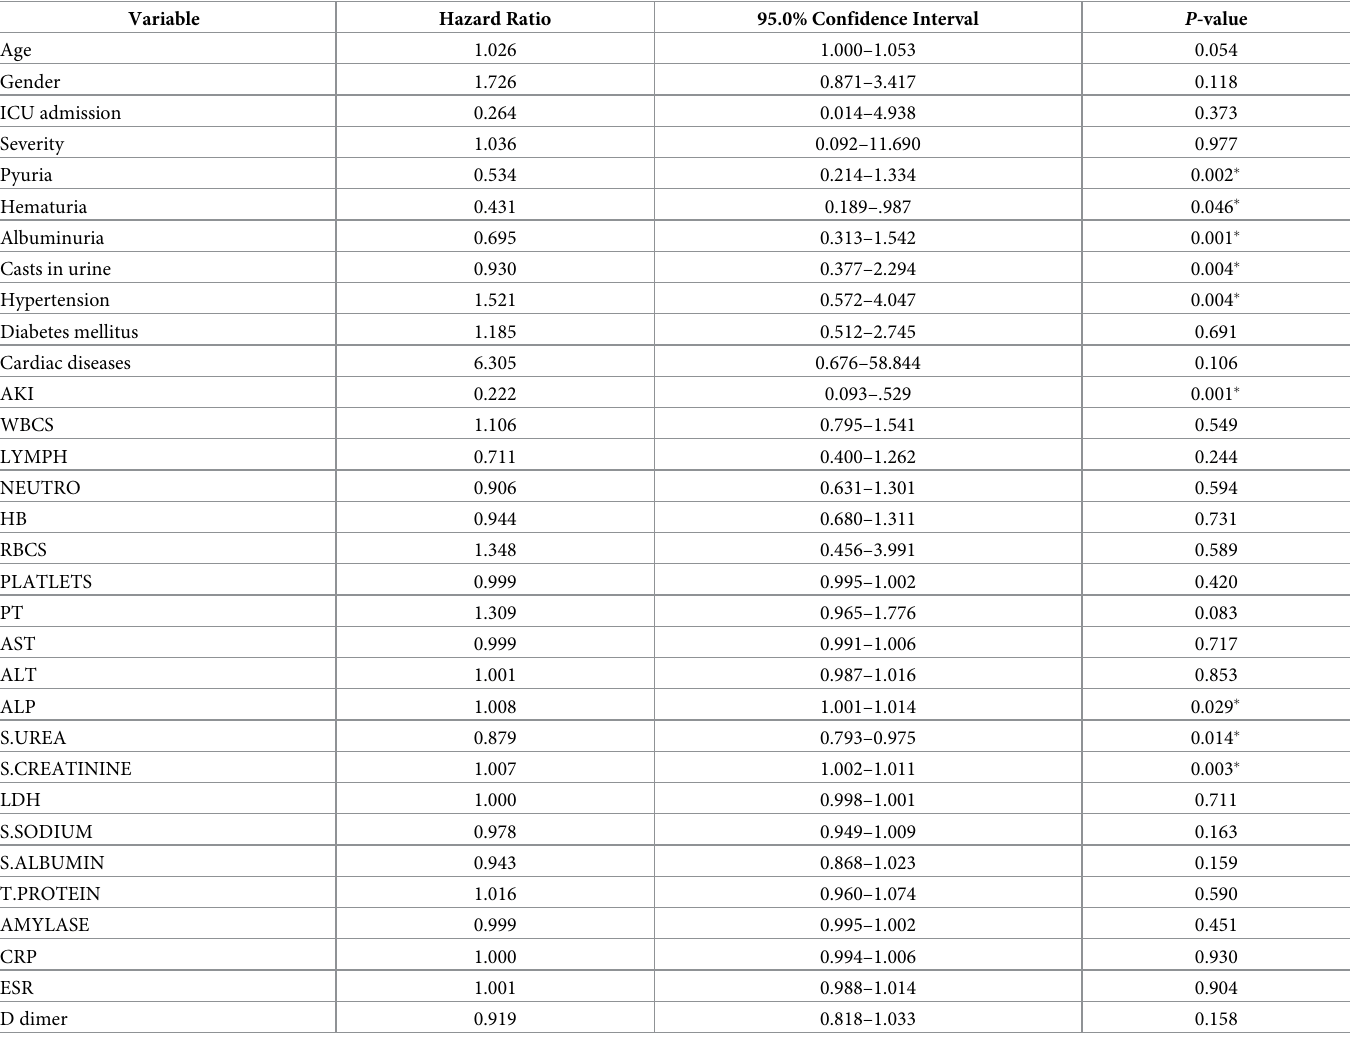
showed that age and hypertension, in addition to renal manifestations in the form of AKI, hematuria, proteinuria, pyuria, and presence of casts, were significant risk factors for mortality in patients with COVID-19 (Table 5). Table 5. Multivariate COX regression analysis of risk factors for mortality among the patients with COVID-19 included in the present study. Variable Hazard